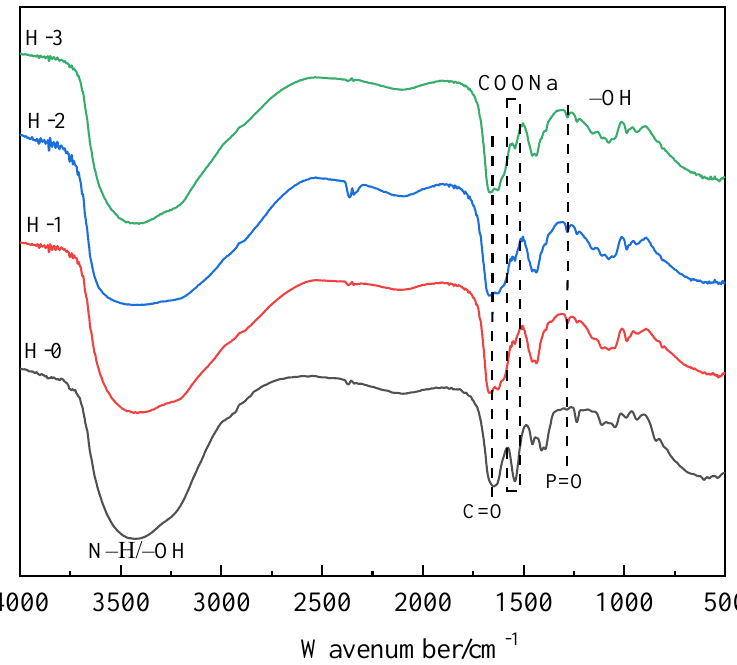
Figure 2. FTIR spectra of transparent flame-retarded hydrogels.